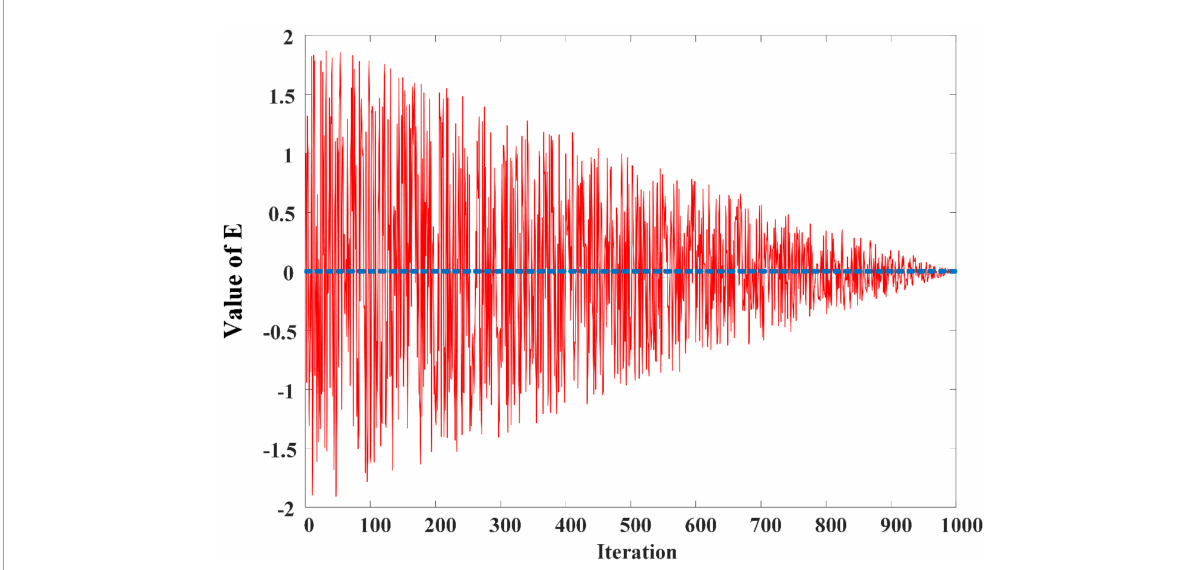
FIGURE2 The change curve of E in 1000 iterations based on Heidari et al.